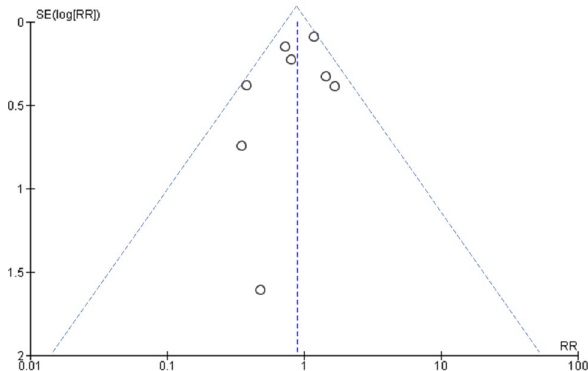
Figure 4. Funnel plot of ACEIs/ARBs users against non-users of ACEIs/ARBs on the risk of mortality in patients with